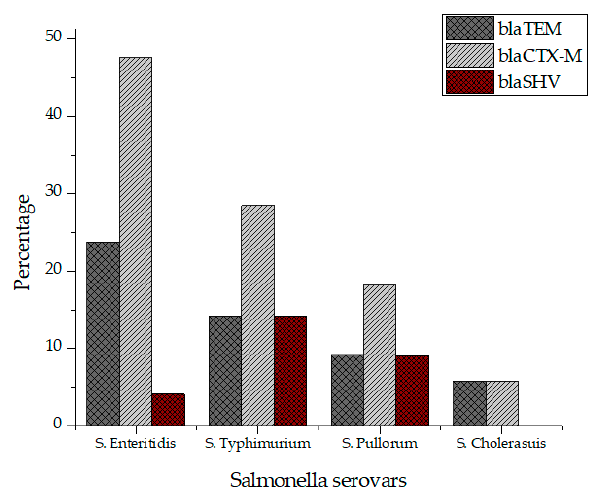
Figure 3. PCR based screening of sopB (220), tolC (161bp) and spaN (504bp). Lane M represents 100bp ladder.